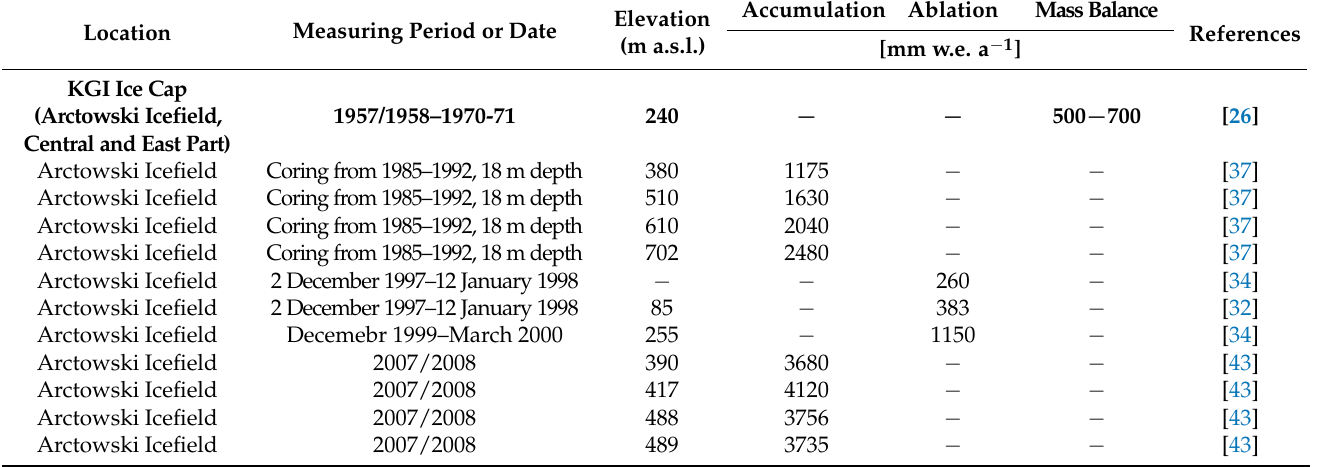
Table A1. The research performed to date on the parameters that compose the mass balance of glaciers on KGI